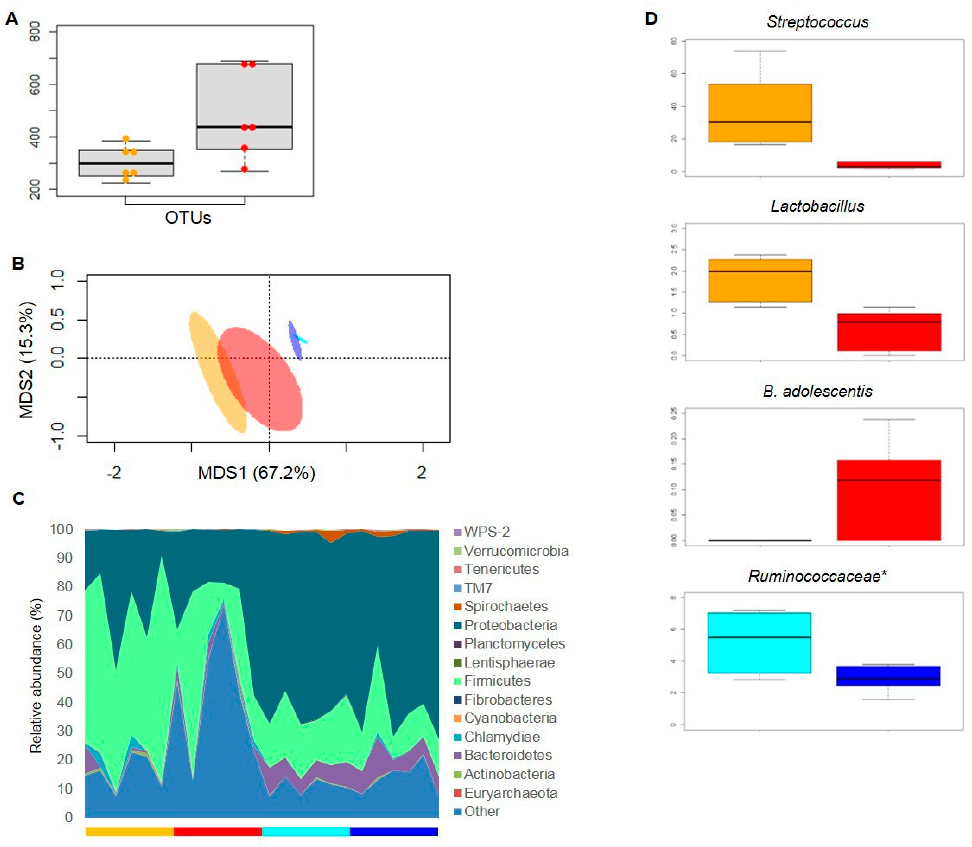
Figure 3. Mucosa-associated microbiota from ileum and colon after einkorn vs. wheat bread-based intervention. ( A ) Box plots showing the distribution of alpha diversity values, according to the observed OTU metrics. Samples are identified with colored dots within boxes (orange: ileal mucosa from wheat bread (WB)-fed pigs; red, ileal mucosa from einkorn bread (EB)-fed pigs). A significant difference between diet groups was found ( p -value = 0.02, Wilcoxon test). ( B ) Principal Coordinate Analysis (PCoA) of weighted UniFrac distances between the mucosal microbial profiles of pigs after 30-day consumption of EB (ileum, red; colon, blue) or WB (ileum, orange; colon, cyan). Ellipses include 99% confidence area based on the standard error of the weighted average of sample coordinates. Only in the ileum compartment, the mucosa-associated microbiota fractions clustered in distinct groups according to diet ( p -value = 0.04, permutation test with pseudo-F ratios). ( C ) Relative abundance of phylum-level taxa in the ileal or colonic mucosal microbiota of EB- vs. WB-fed pigs. Bars that are below the area chart are colored according to diet and intestinal compartment, as in ( B ). ( D ) Box plots showing the distribution of the relative abundance values of discriminant taxa between the EB and WB group, at the ileum or colon level. Same color code as in ( B ). *, unclassified OTU reported at higher taxonomic level. p value < 0.05, Wilcoxon test.